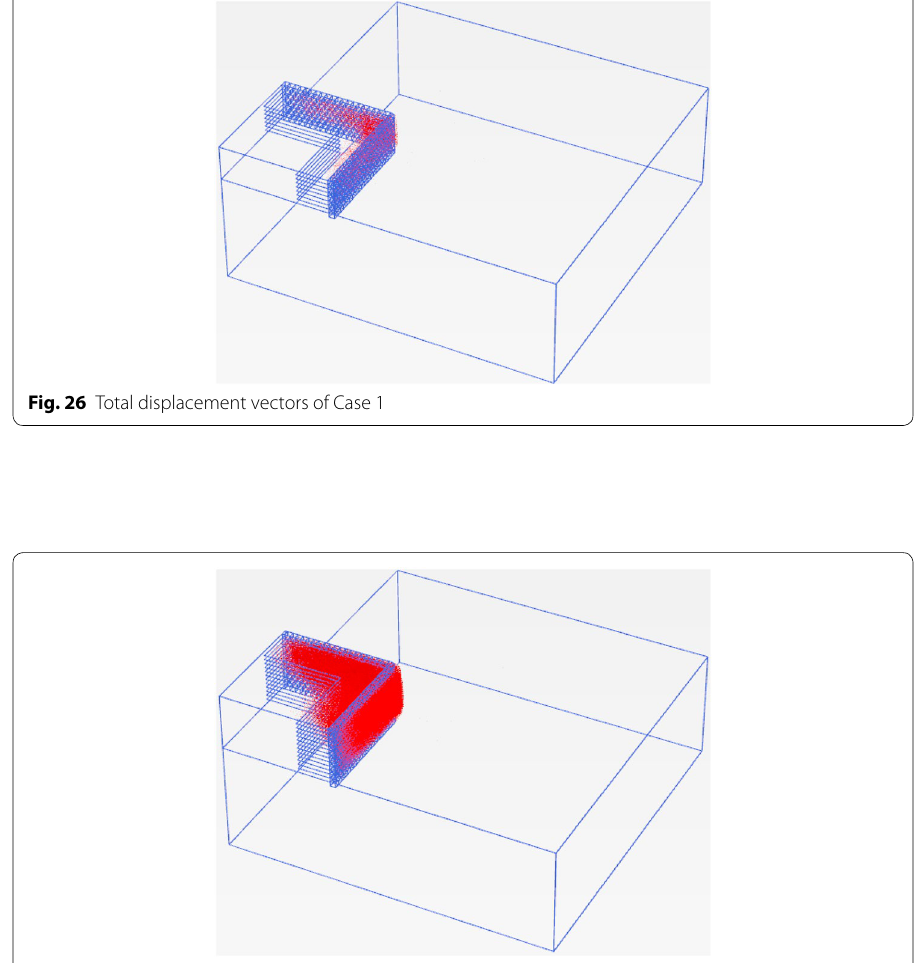
Fig. 27 Total displacement vectors of Case